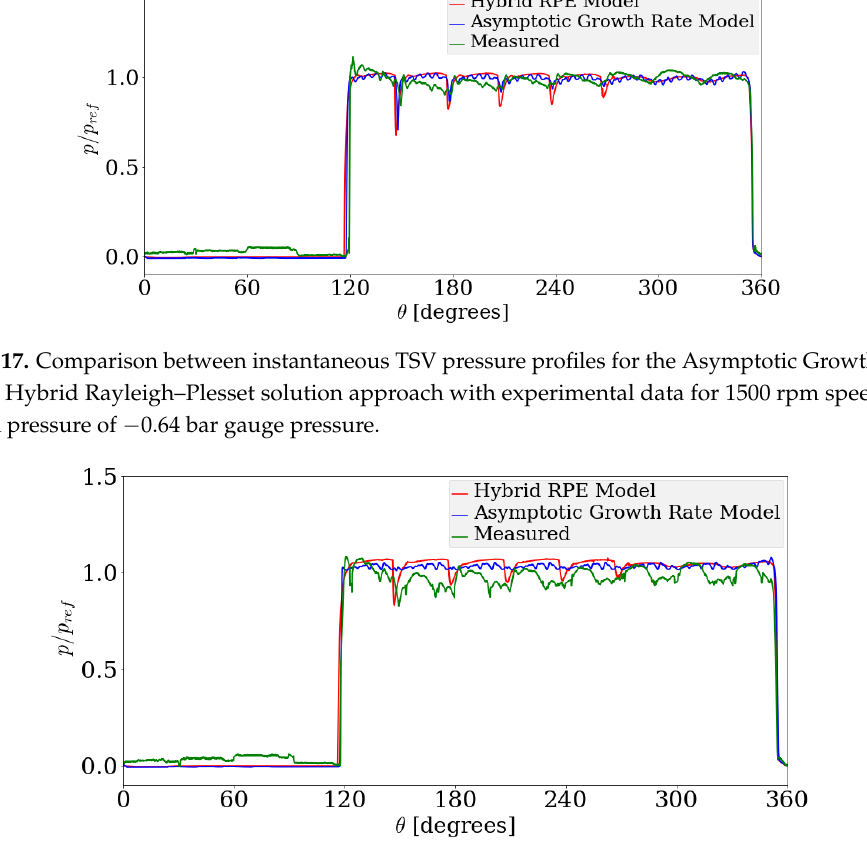
Figure 18. Comparison between instantaneous TSV pressure profiles for the Asymptotic Growth Rate model, Hybrid Rayleigh–Plesset solution approach with experimental data for 2000 rpm speed and suction pressure of − 0.72 bar gauge